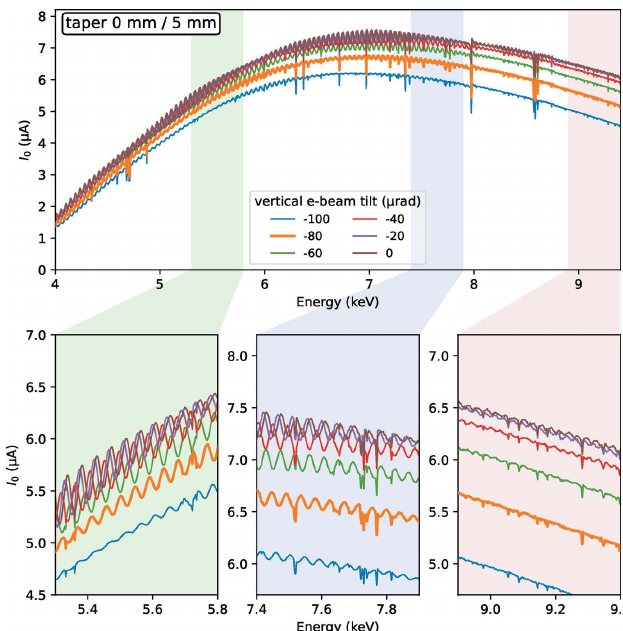
Figure 2 Experimental wiggler spectra measured as intensity upstream of the sample ( I 0 ) during quick energy scans at various e-beam inclination and taper values of the magnetic gap. The typical operational inclination value is (cid:6) 80 m rad, shown by a thicker orange line. An animated version of the figure can be found in the supporting information.